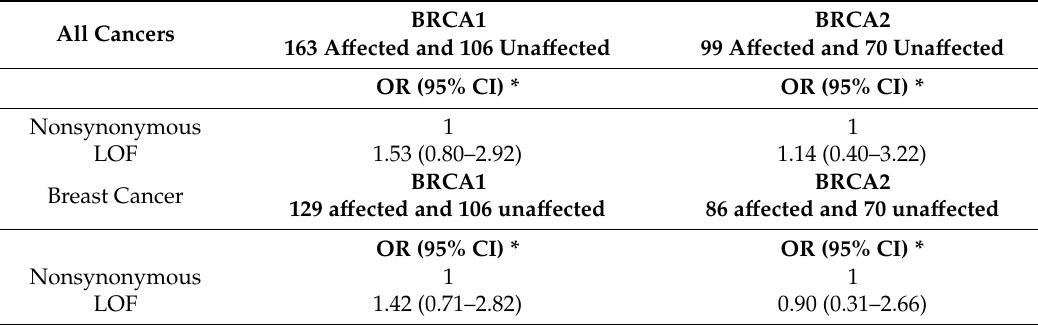
Table 2. Association between BRCA-related cancer risk and variant